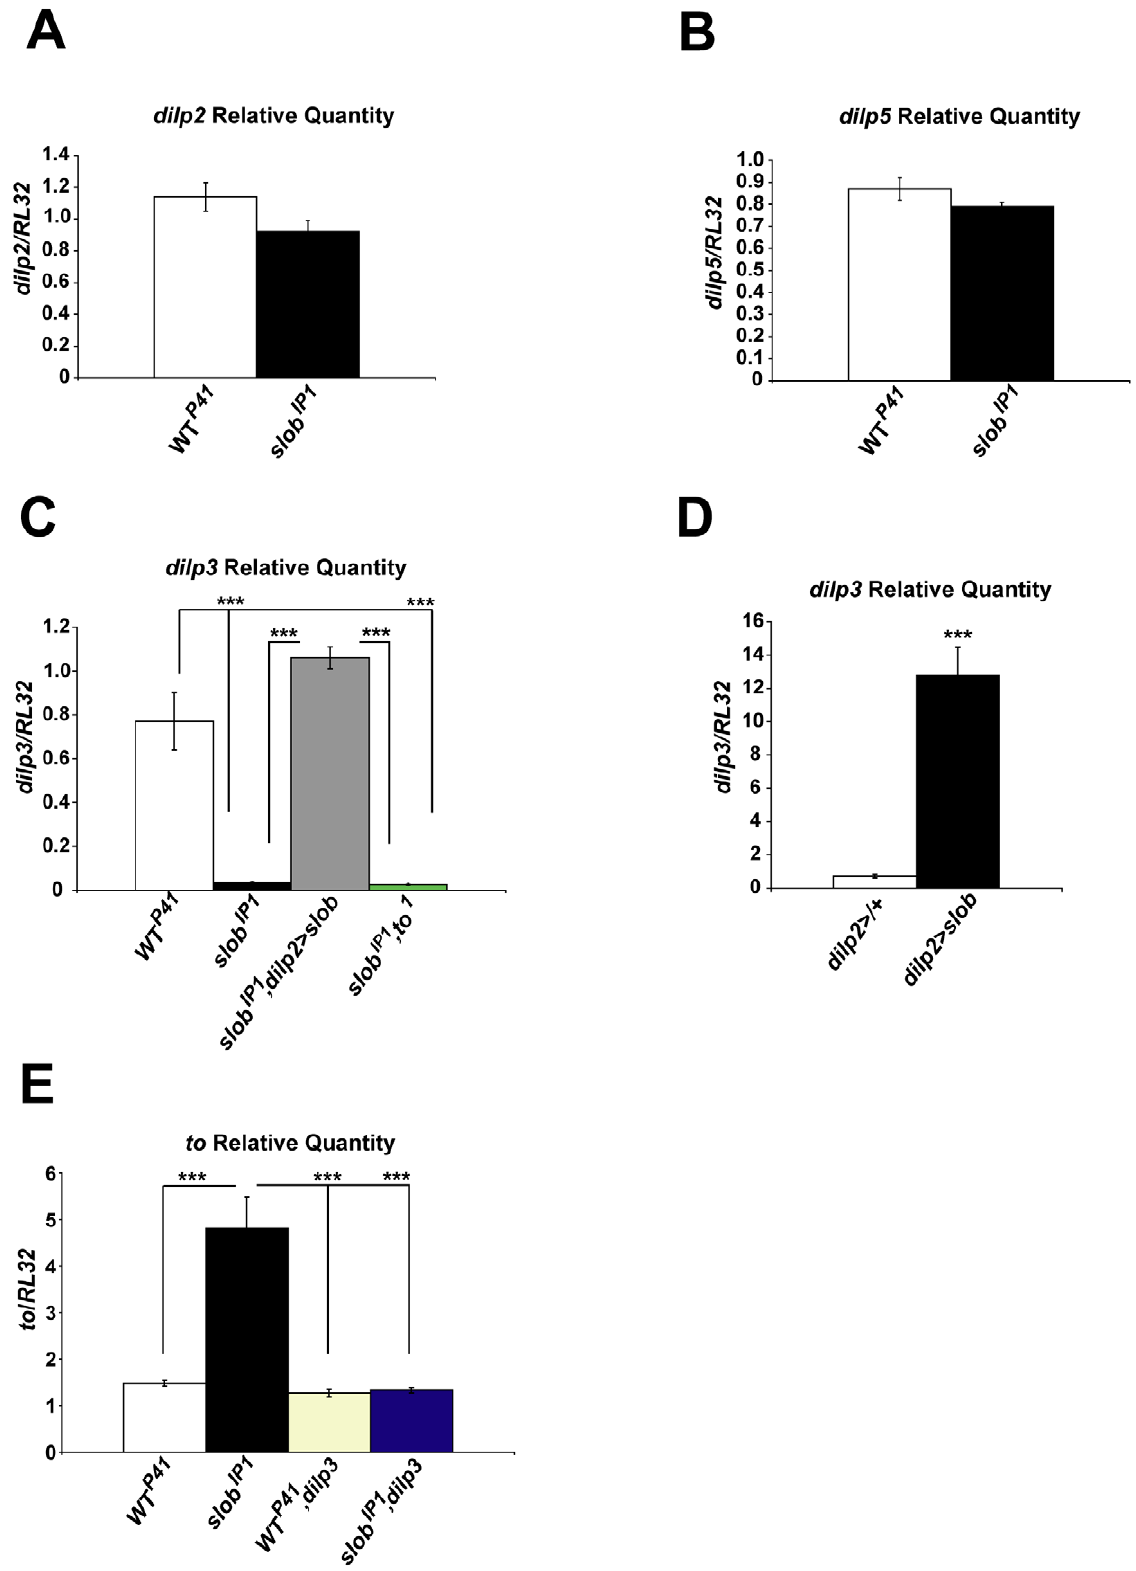
Figure 5. Effect of SLOB on expression of dilps . Relative dilp2 , - 3 , and - 5 transcript levels in fly heads were measured by qPCR. A,B , Relative dilp2 or dilp5 transcript levels are unchanged in slob IP1 fly heads. C , Relative dilp3 transcript levels are reduced in slob IP1 fly heads and rescued by expression of SLOB in mNSCs, but not by mutation of to . D, Relative dilp3 transcript levels are increased in heads of flies overexpressing SLOB in mNSCs. E, The increase in to levels is abolished in slob IP1 ,dilp3 fly heads. Each graph is a summary of a minimum of three independent experiments (mean 6 SEM). *** indicates p , 0.001, One-way ANOVA with Bonferroni post-test ( C, E ) or Student’s t-test ( D ). doi:10.1371/journal.pone.0023343.g005 PLoS ONE |